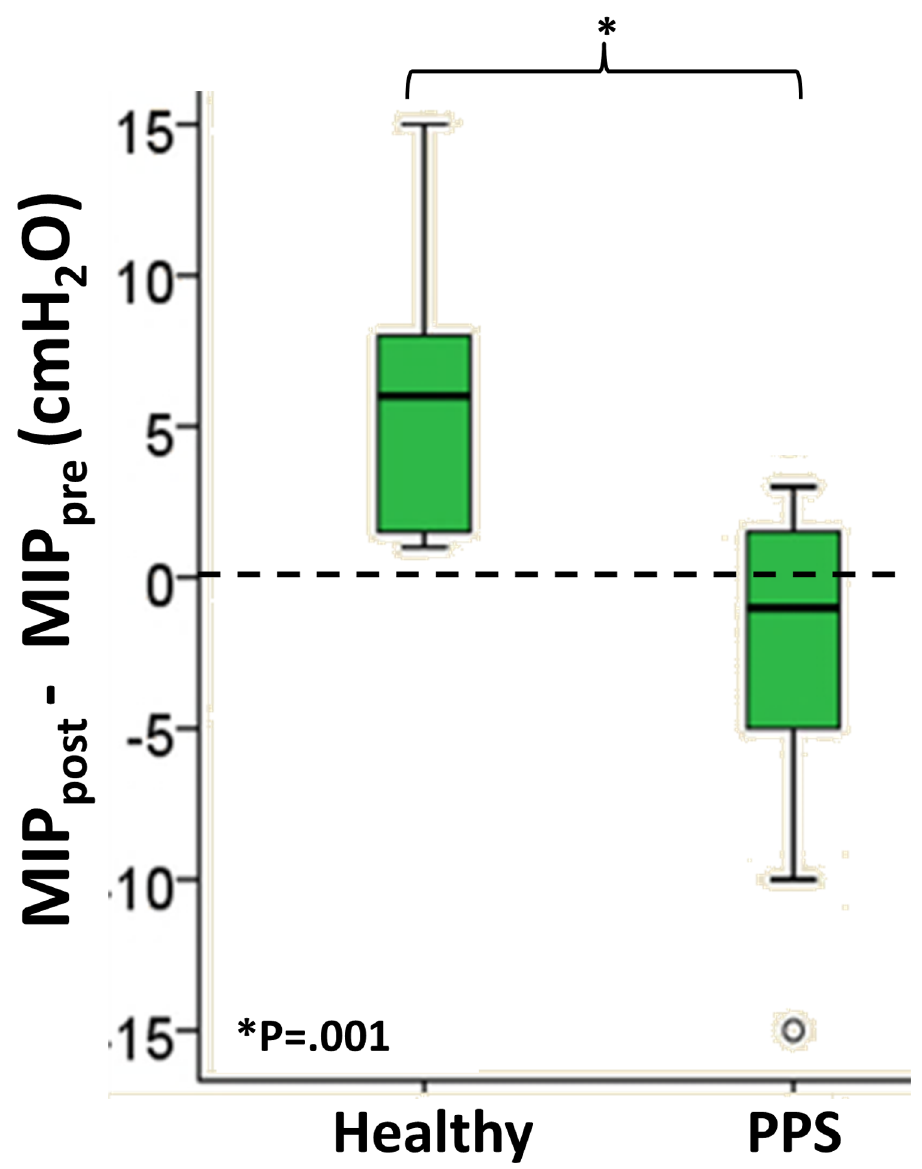
Fig 2. Differencein Maximal Inspiratory Pressure(MIP) before and after Maximal Voluntary Ventilation (MVV) maneuvers in the control and Post Polio Syndrome (PPS) groups.